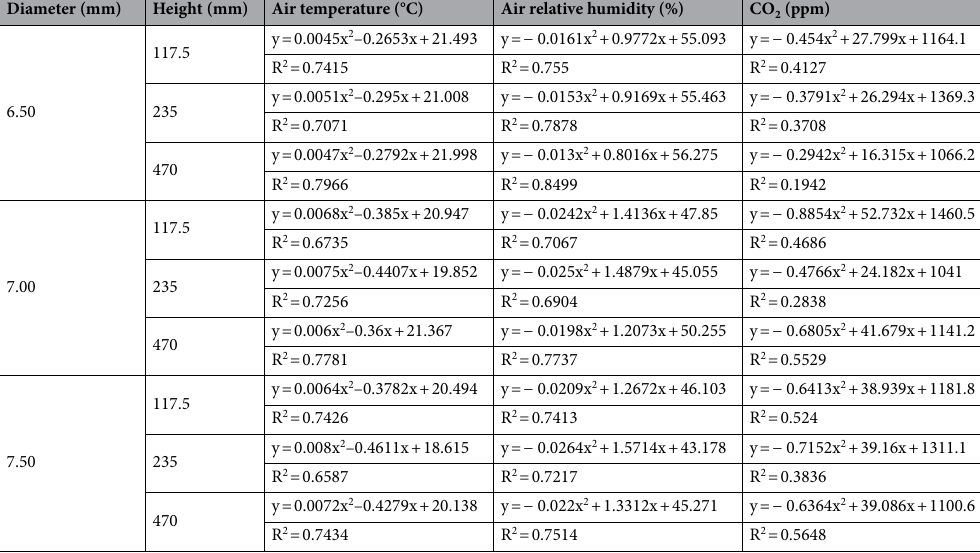
Table 3. Polynomial regression equations for air temperature (°C), air relative humidity (%) and CO 2 (ppm) of corn grain mass at 16% moisture content in tubes with different hole diameters and heights